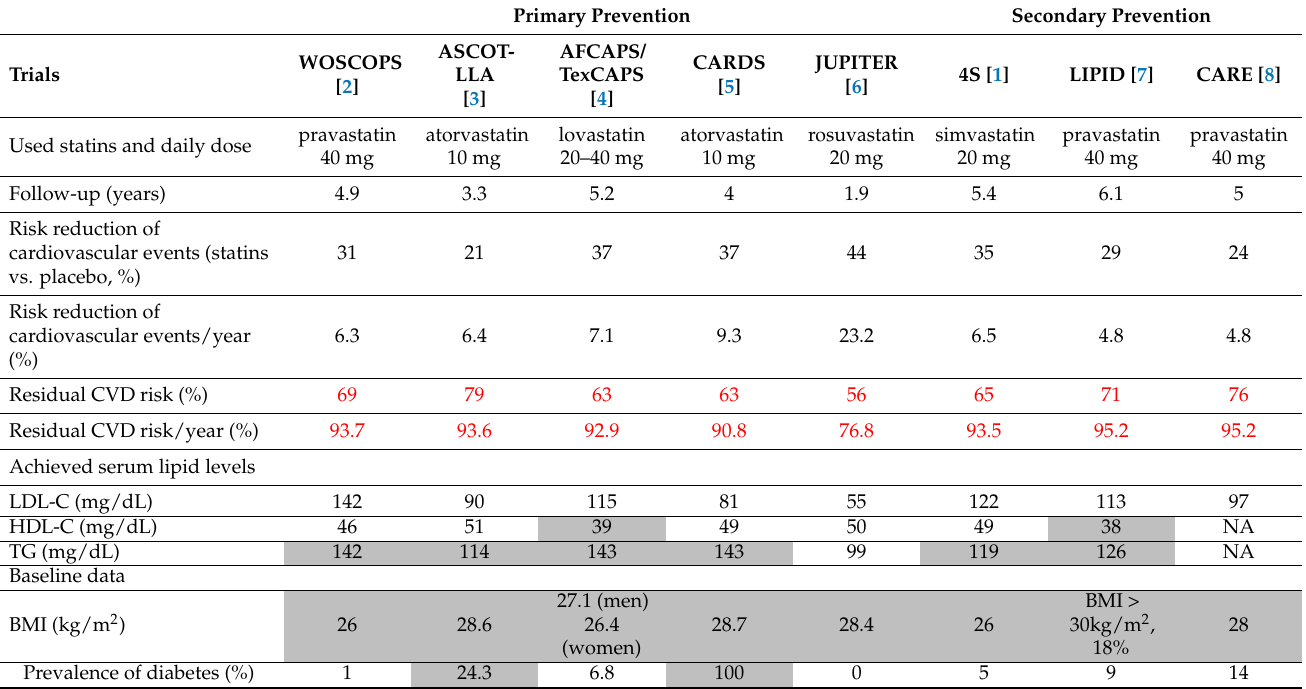
Table 1. Randomized, double blind, placebo-controlled trials to study the effect of statins on develop- ment of caridovascular